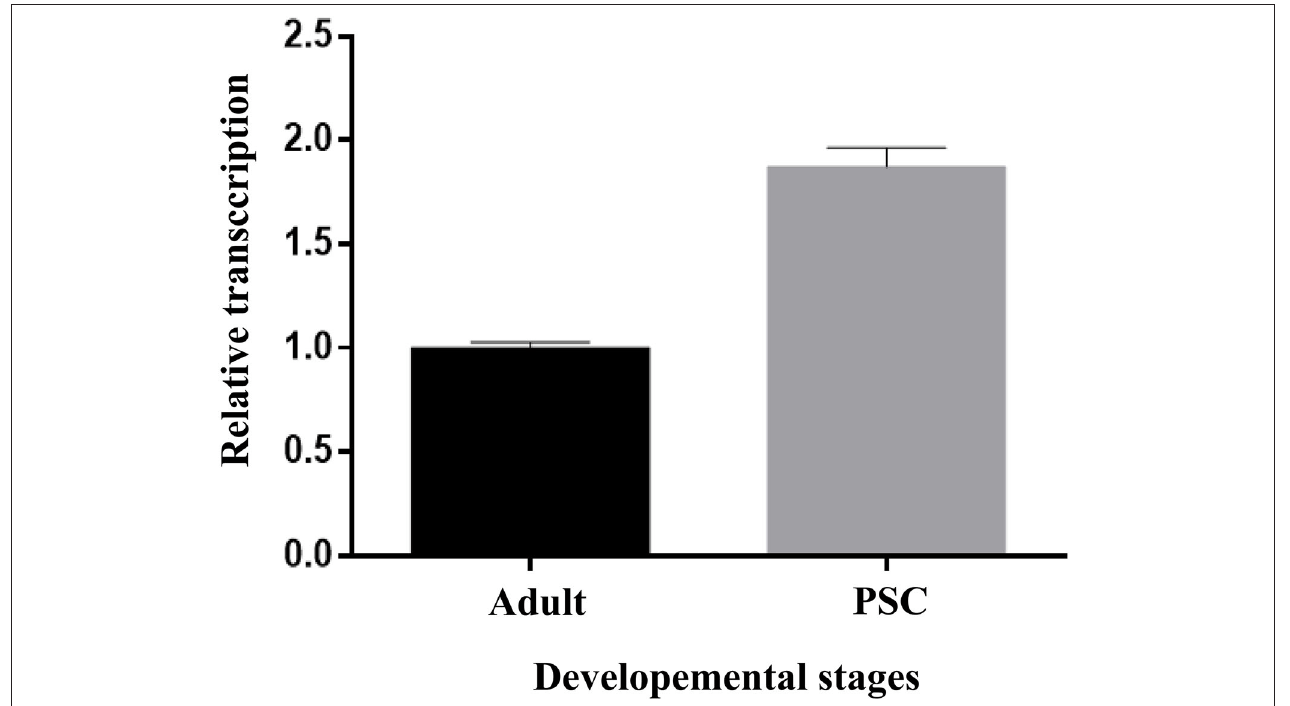
FIGURE 6 | Expression analysis of Eg-TSP11 mRNA in different developmental stages of E. granulosus